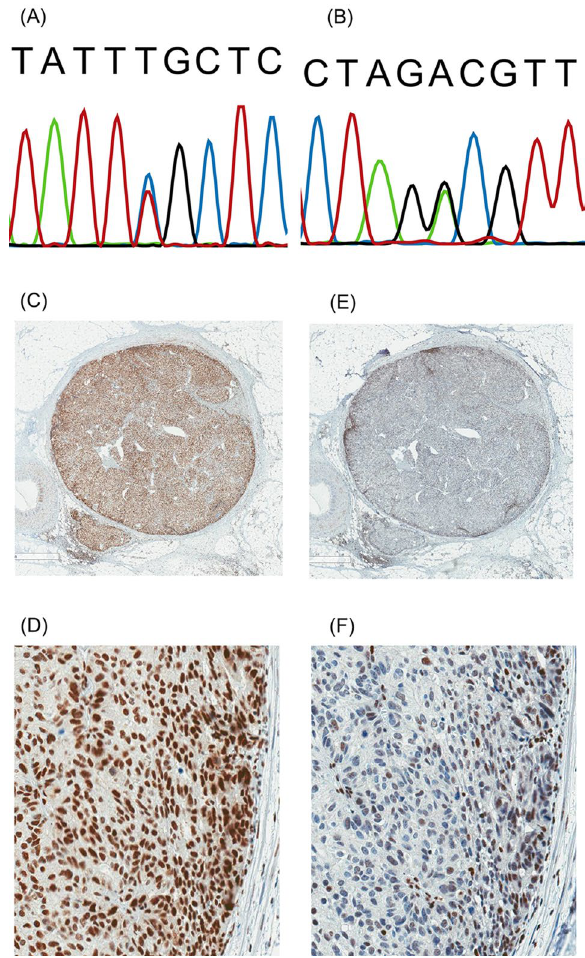
Figure 2. MMR gene variants and IHC heterogeneity in the second cohort. ( A ) Sanger sequencing of the variant (chr3:g.37053562 C>T; NM_000249.3: c.649 C>T, p.Arg271Cys), in case 1. ( B ) Sanger sequencing of the variant (chr3:g.37035011 A>G; NM_000249.3:c. − 28 A>G), in case 7. ( C – F ) Case 4 showed intact MLH1 ( C , D ), with heterogeneous staining of PMS2 (intra-glandular loss in ( E , F )) in a gastric cancer